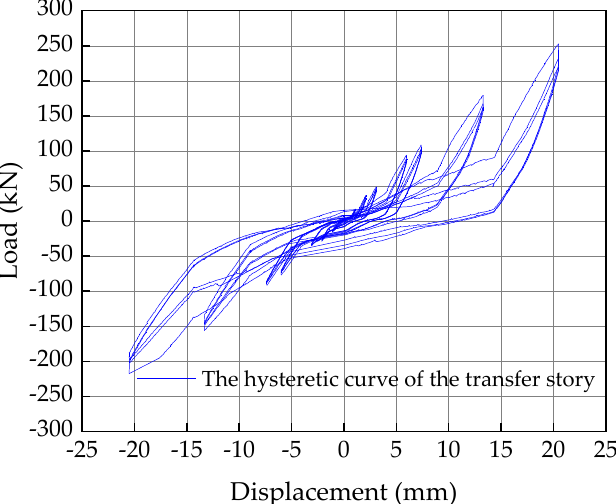
Figure 22. The hysteretic curve of the transfer story.